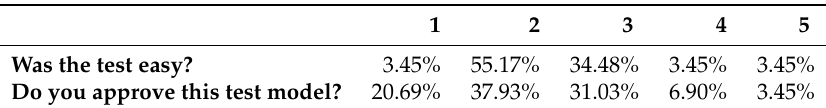
Table 10. Assessment of the sync